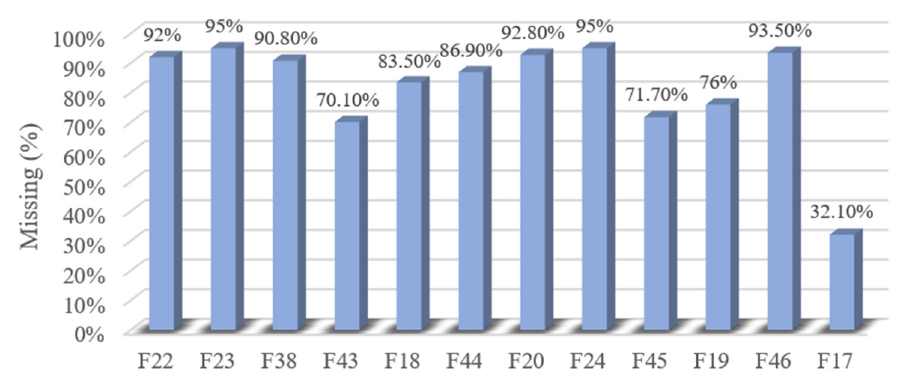
Figure 4. The MCAR pattern analysis of the IRDia dataset. -MAR pattern analysis: Figure 5 shows the percentage of the MAR pattern for 27 fea-